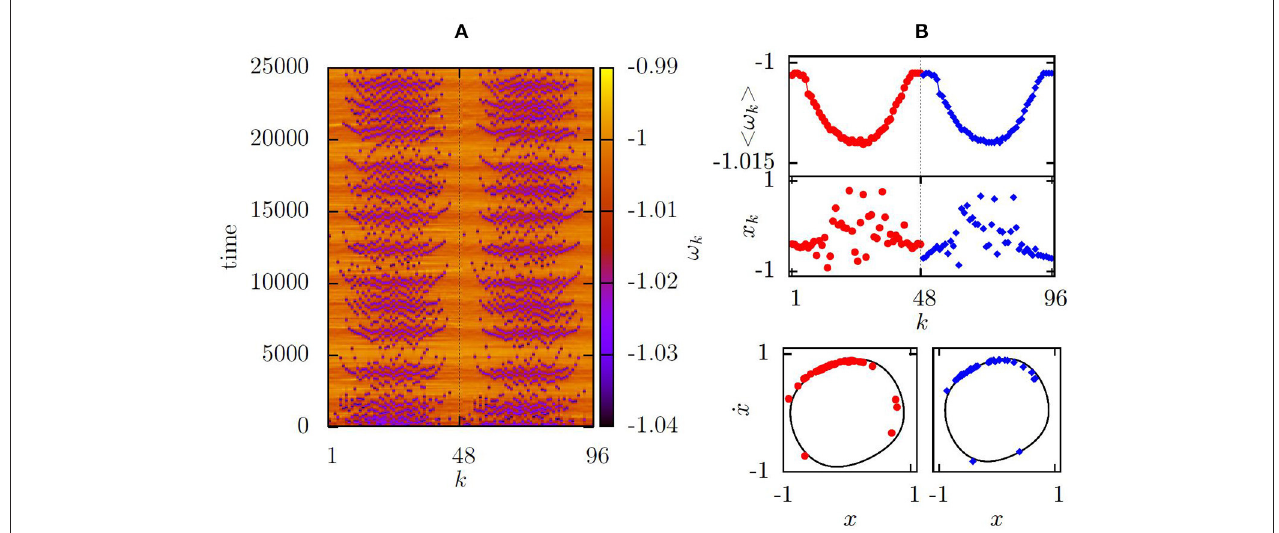
FIGURE 7 | Same as Figure 6 with R 1 = 16, R 2 = 12, and K a =